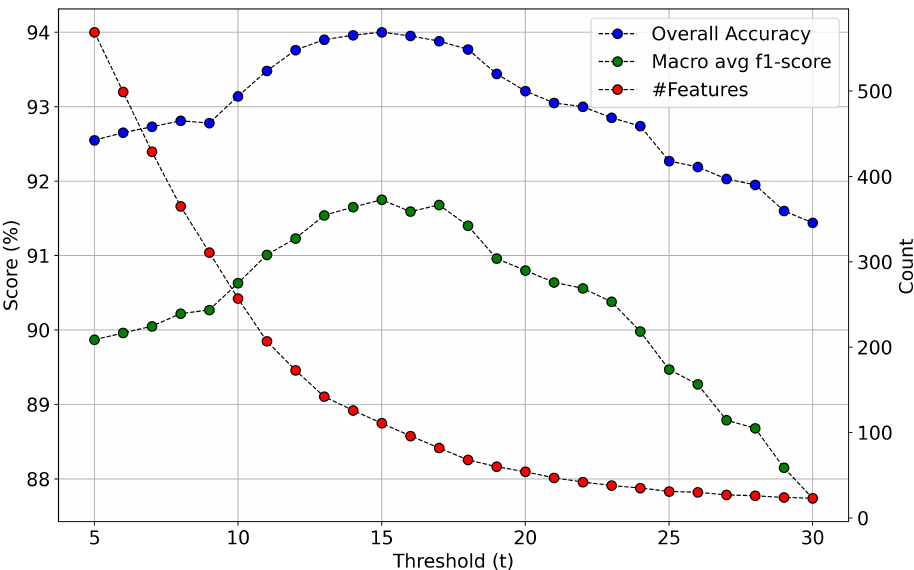
Figure 7. The performance of the SVM algorithm trained with features obtained when we apply the threshold t, in the different 100 subsets results from the GA experiments. The blue and the green lines present the OA and macro averaged f1-score, respectively, and are associated with the left y-axis. The red line indicated the number of features for each different run and is associated with the right y-axis.